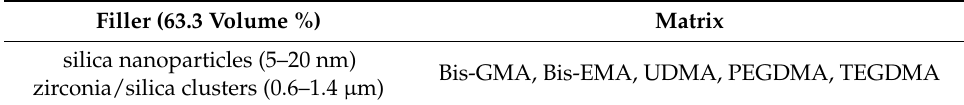
Table 1. The composition of nanohybrid composite (Filtek Z350XT) used in this study. Filler (63.3 Volume